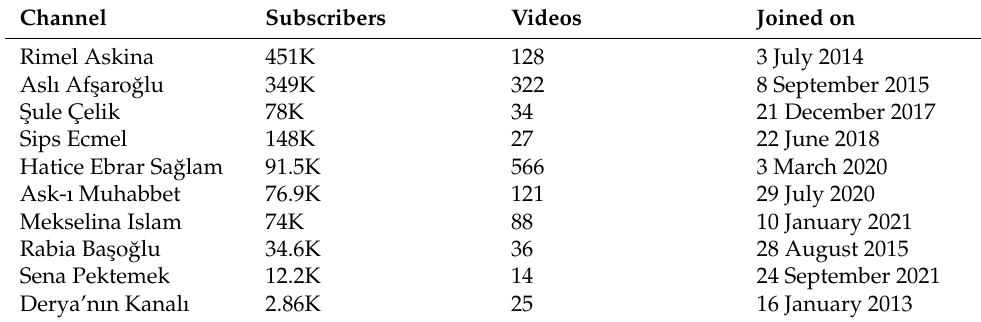
Table 1. Hijabi YouTubers in Turkey.